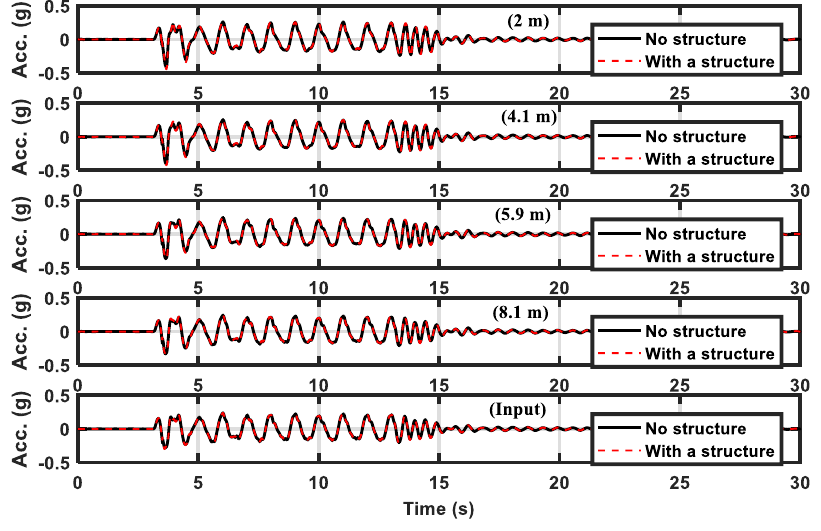
Figure 11. Acceleration time histories in the free-field soil.